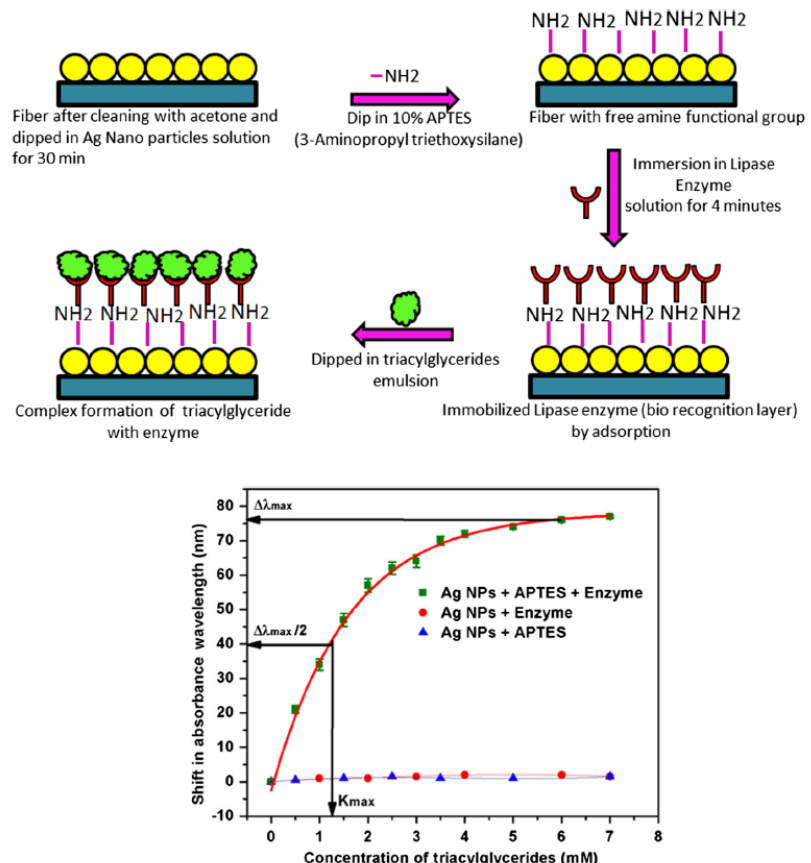
Figure 3. (top panel) The schematic of the process of lipase enzyme immobilization to create the biorecognition surface on the plasmonic fiber-optic sensor. (bottom panel) Peak absorbance wavelength shift as a function of triacylglycerides concentration in pH 7.4 solution at 37 °C standard deviation with APTES and enzyme, with APTS only and with enzyme only. Figures reproduced under the terms of the CC-BY Creative Commons attribution 4.0 from Reference [26], Copyright 2017.